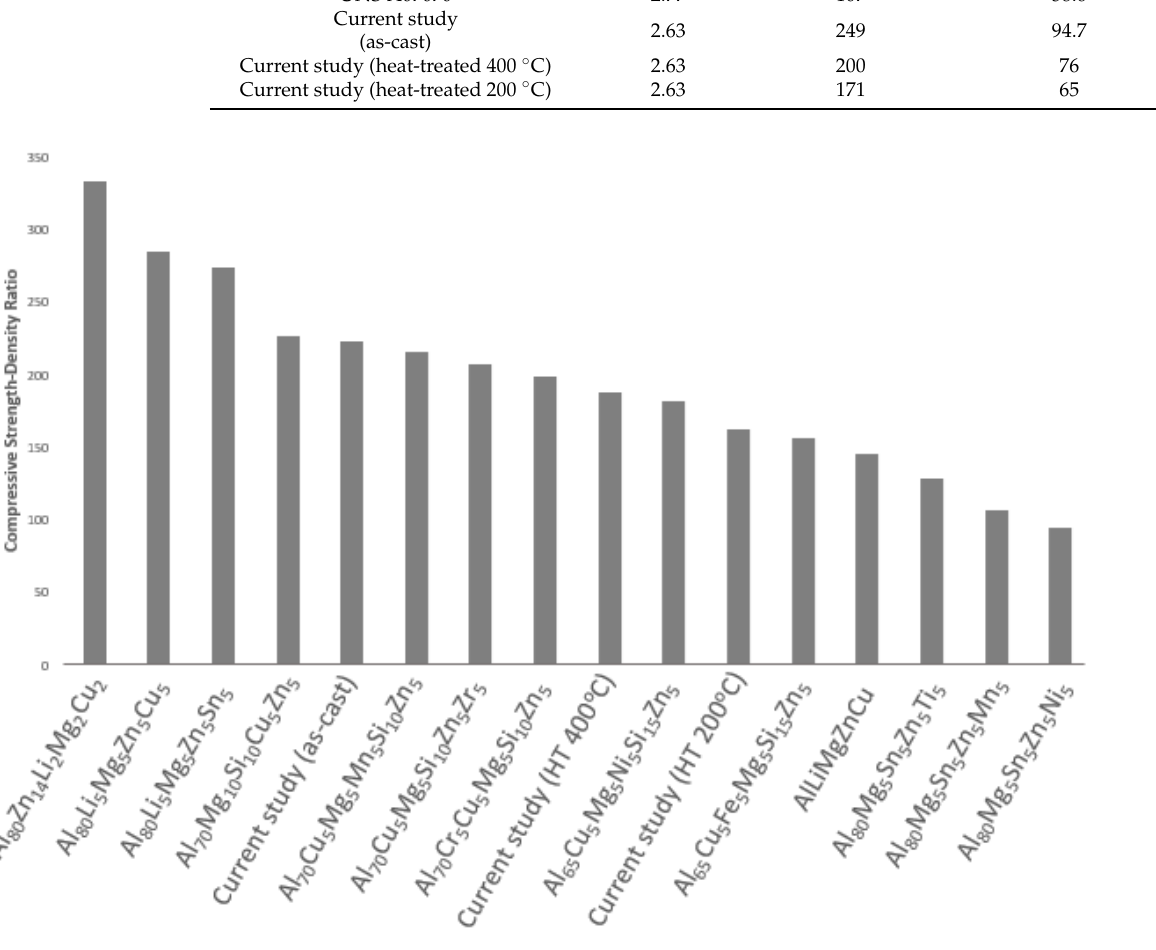
Figure 13. Comparative diagram of compressive strength and density ratio for current study and various alloys in literature [5,20,23,26 – 28].